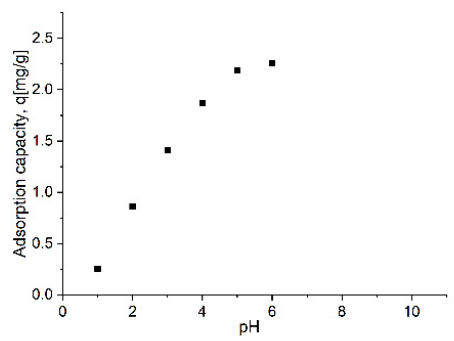
Figure 8. The effect of pH on the adsorption of Pb 2+ ions on the magnetic nanocomposite MNPs35@SiO 2 .